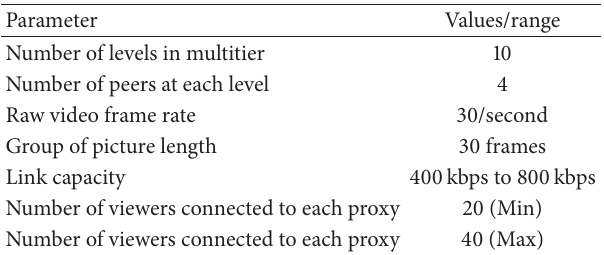
Table 1: Simulation